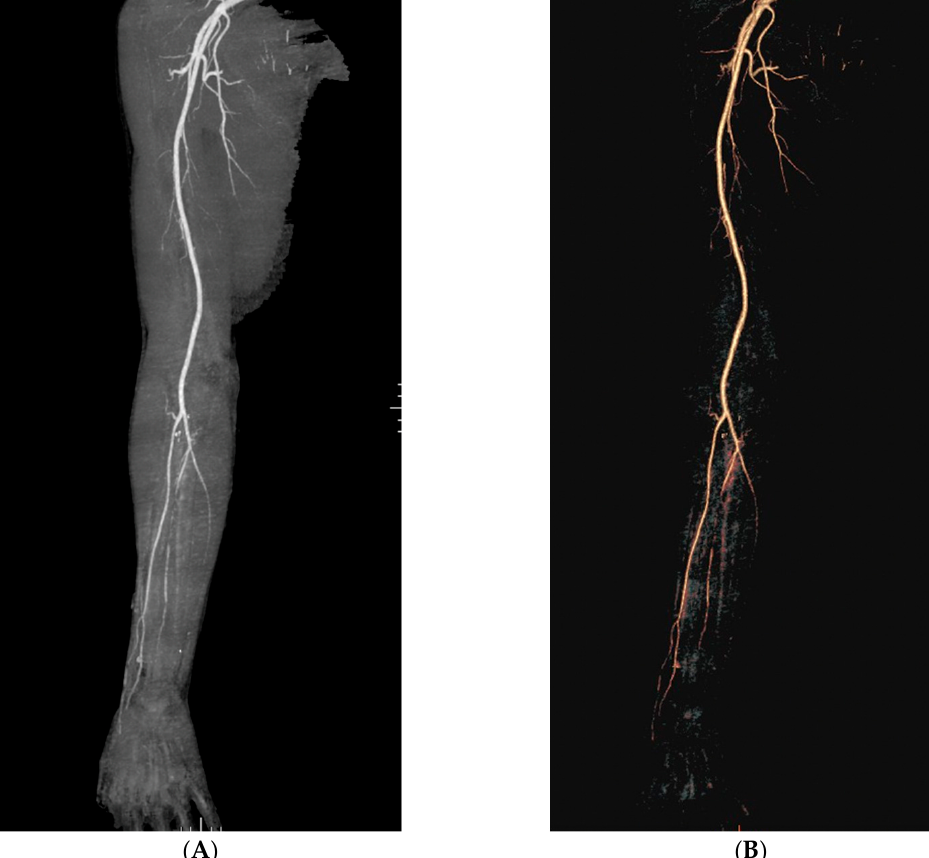
Figure 2. ( A ) Angio-TC 3D images MIP and ( B ) VRT demonstrating progressive thinning of the ulnar artery, occluded in its distal segment about at the half of the forearm.